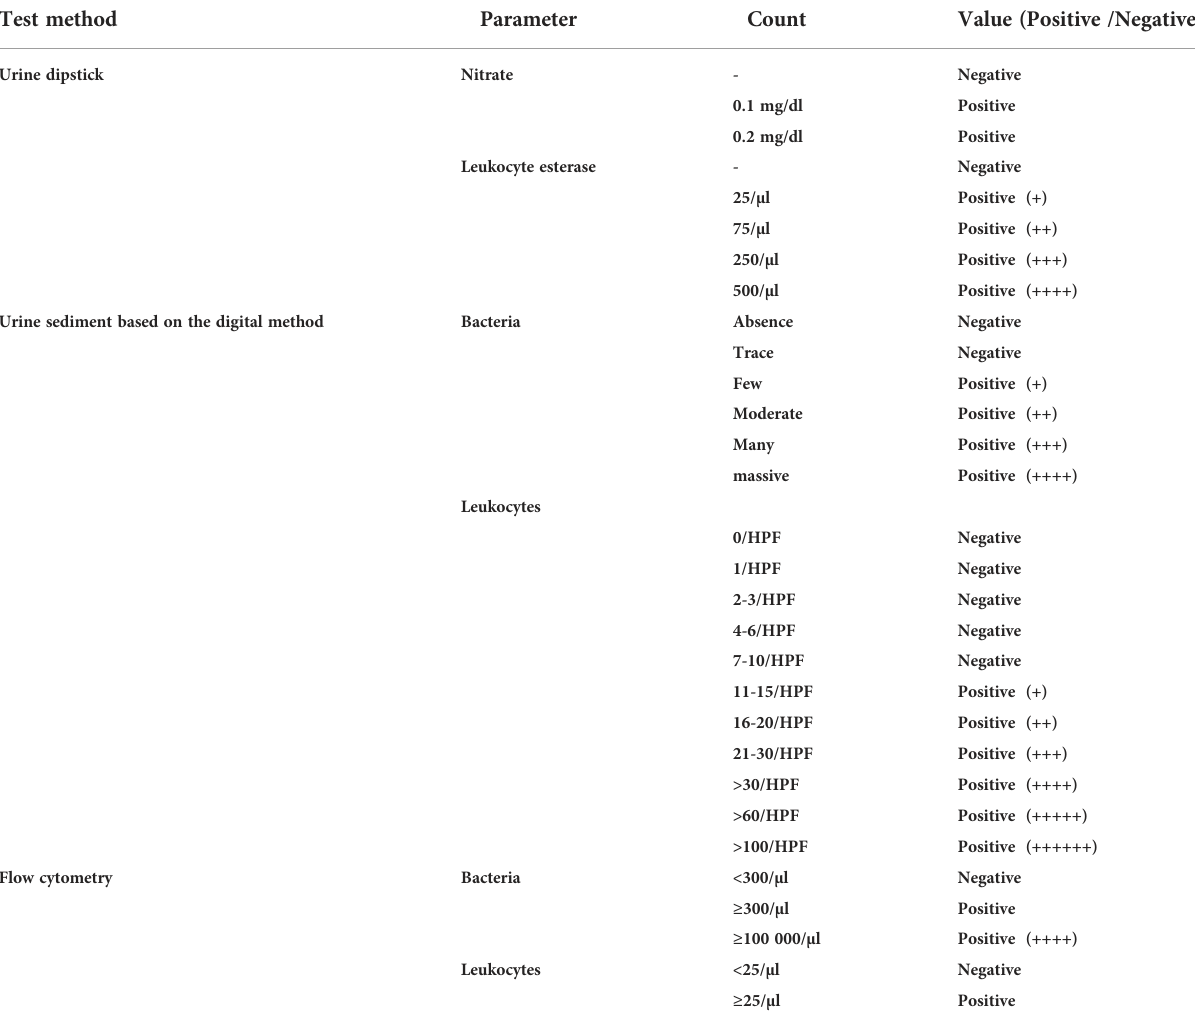
TABLE 3 Possible test results of three methods.